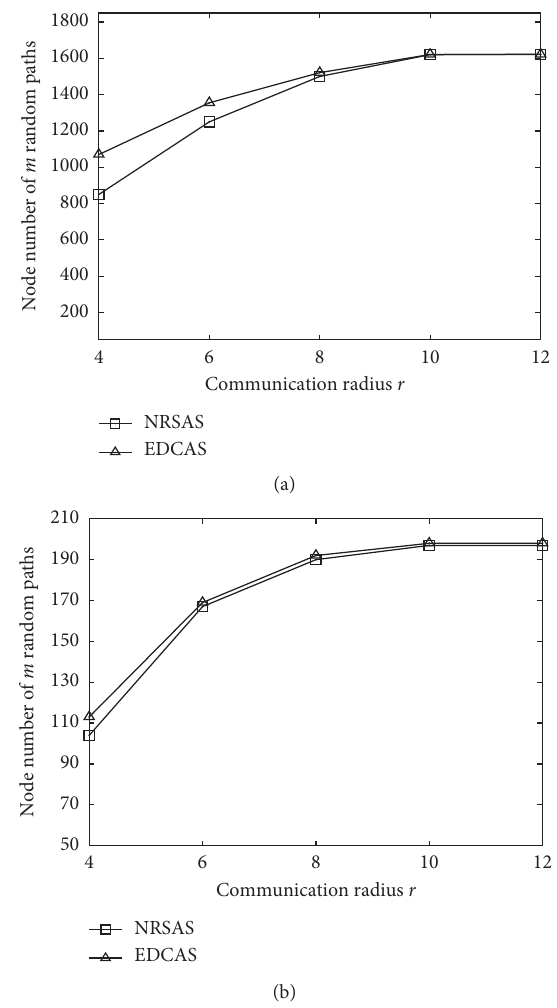
Figure 12: The effect of the communication radius on the random path. (a) Synthetic dataset. (b) IntelLab dataset.